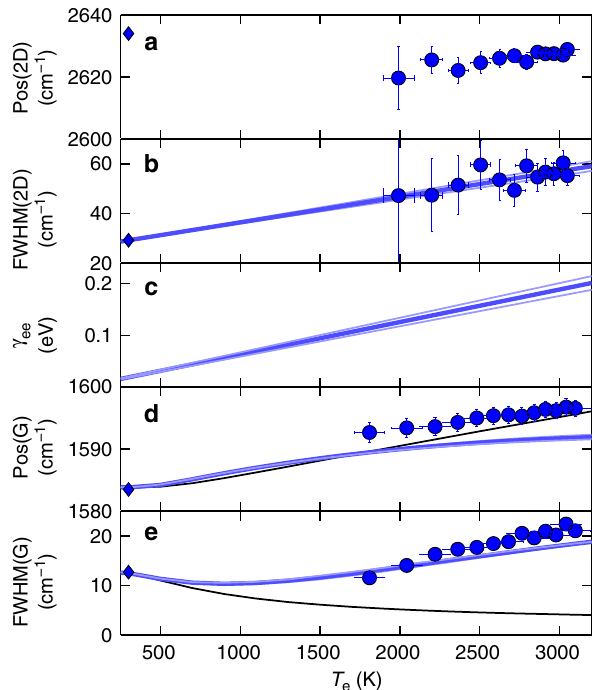
Fig. 3 Comparison between theory and experiments. a Pos(2D), b FWHM(2D), d Pos(G), e FWHM(G) as a function of T e for ps-excited Raman spectra. Error bars represent the 95% con fi dence level in the best fi tting procedure. Solid diamonds in a,b,d,e represent the corresponding CW measurements. FWHM(2D) are used to determine the e – e contribution ( γ ee ) to the Dirac cones broadening, shown in c (blue lines). Pos(G) and FWHM(G) are compared with theoretical predictions accounting for e – ph interaction in presence of electronic broadening (an additional RT anharmonic damping ∼ 2 cm − 1 10 is included in the calculated FWHM(G)). Black lines are the theoretical predictions for γ ee = 0 eV, while blue lines take into account an electronic band broadening linearly proportional to T e ( γ ee = α e k B T e ). From the fi t of γ ee in c , we get α e k B hc = 0.51 cm − 1 K − 1 (thickest blue line). Values of α e k B hc = 0.46,0.55 cm − 1 K − 1 , corresponding to 99% con fi dence boundaries, are also shown (thin light blue